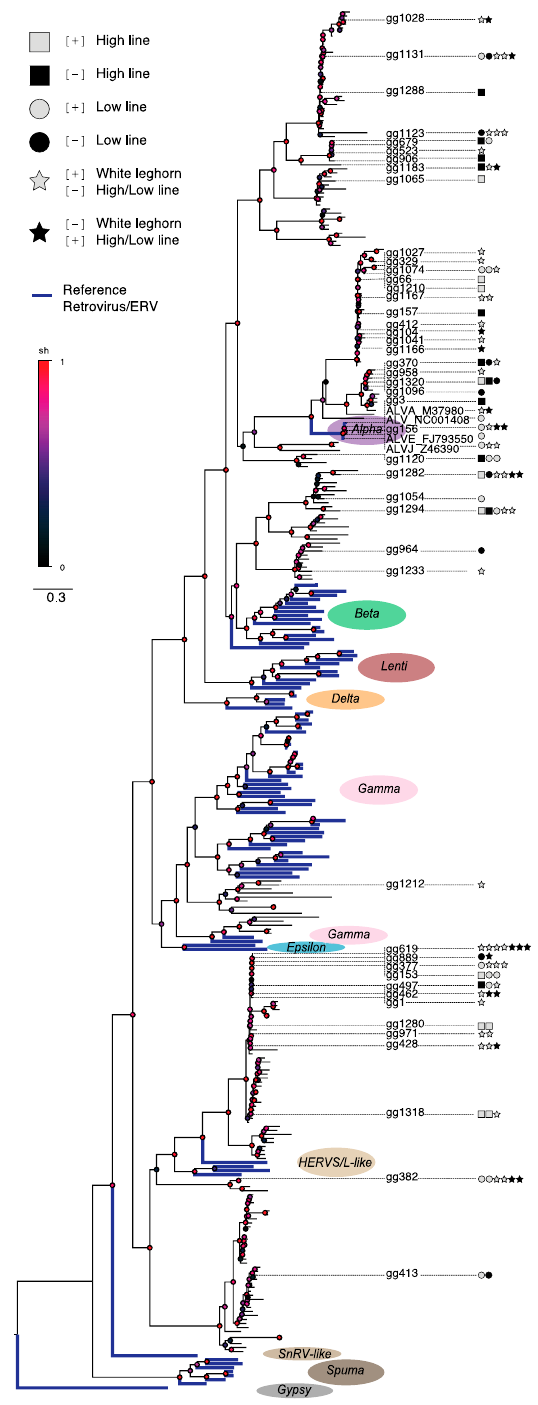
Figure 3. Chicken ERV phylogenetic tree based on Gag and Pol motifs as previously described [4,25]. Thick blue lines indicate reference retroviral and ERV sequences. Candidate ERV-associated loci differences between the H, L, and W chicken are indicated by symbols next to the ERV IDs referring to the RetroTector analysis of the chicken (galGal3) assembly (see FASTA sequences and loci annotations in Supplementary Information Data S1). The complete phylogenetic tree is presented in nexus file format (Supplementary Information Data S2) for rendering in a tree drawing software such as FigTree.